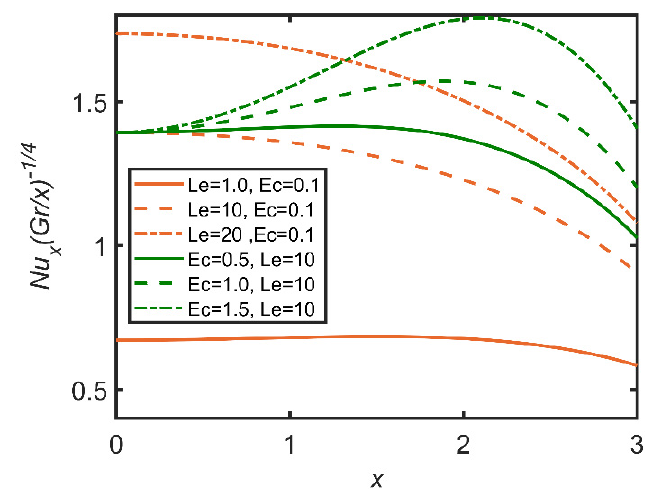
Figure 25. Comparison for Nusselt number against x.